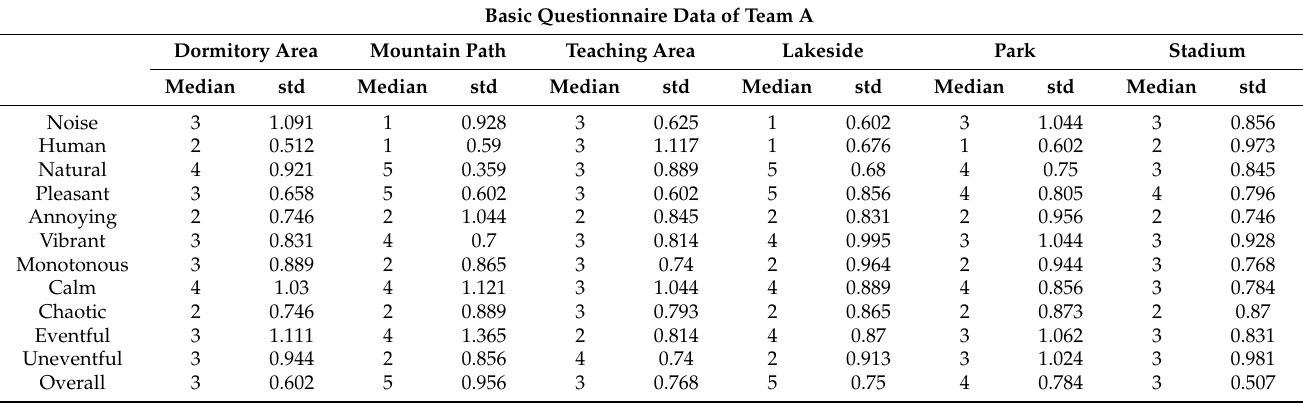
Table 2. Basic questionnaire data of the two teams. Basic Questionnaire Data of Team